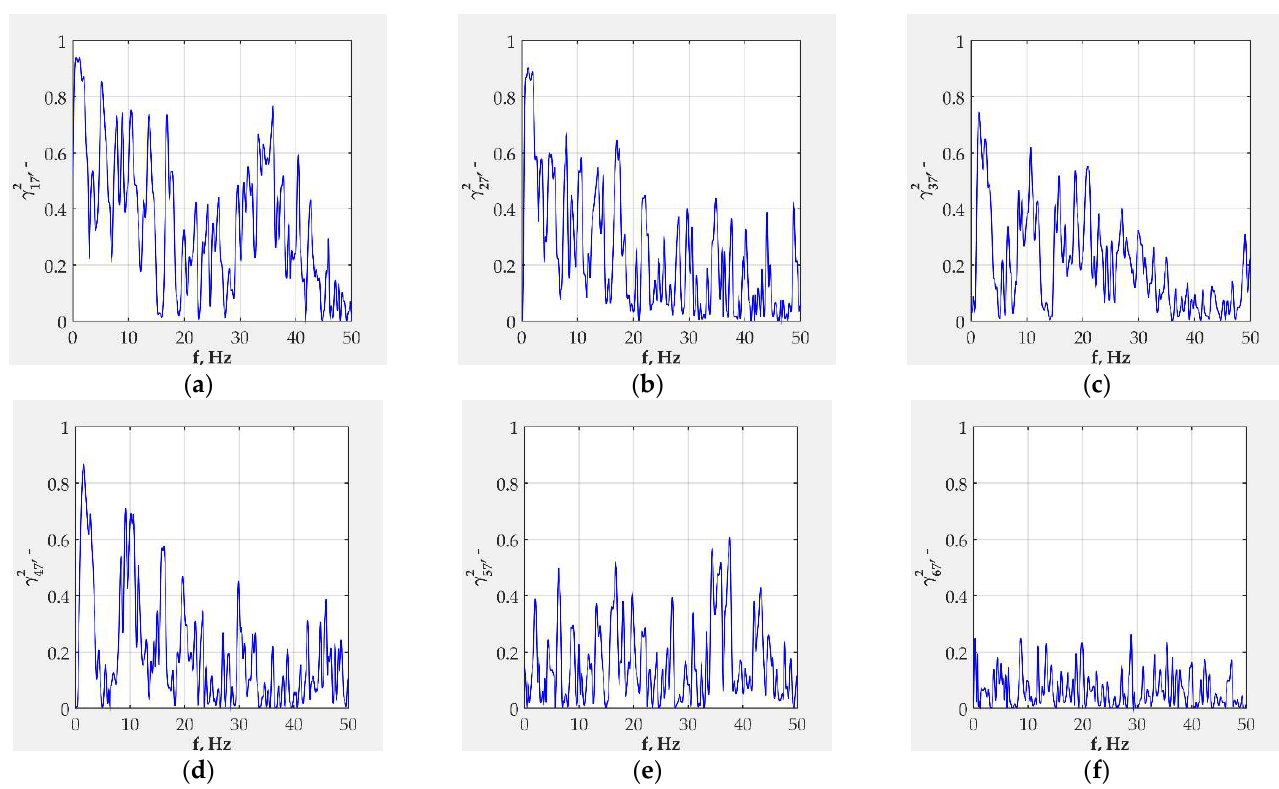
X for the transfer Figure 16. Ordinary coherence functions between the inputs and the output X 7 for the transfer 7